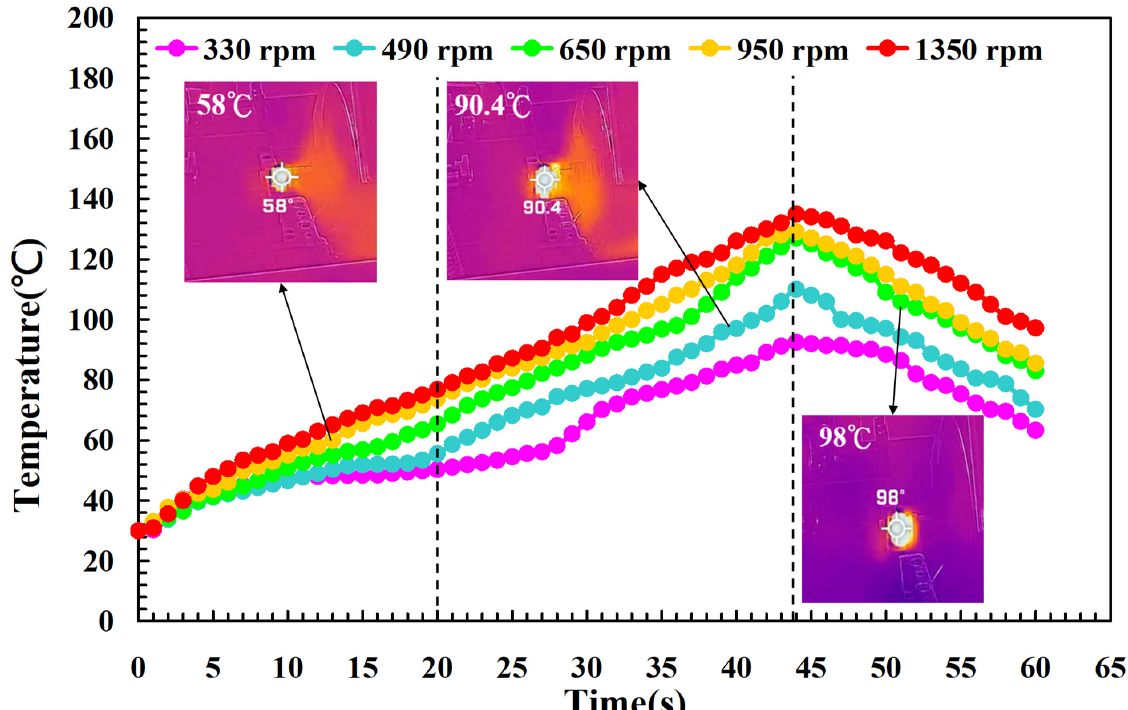
Figure 7. The relationship between weld-joint temperature and FW time for the PLA and PLA rods at five different rotational speeds.